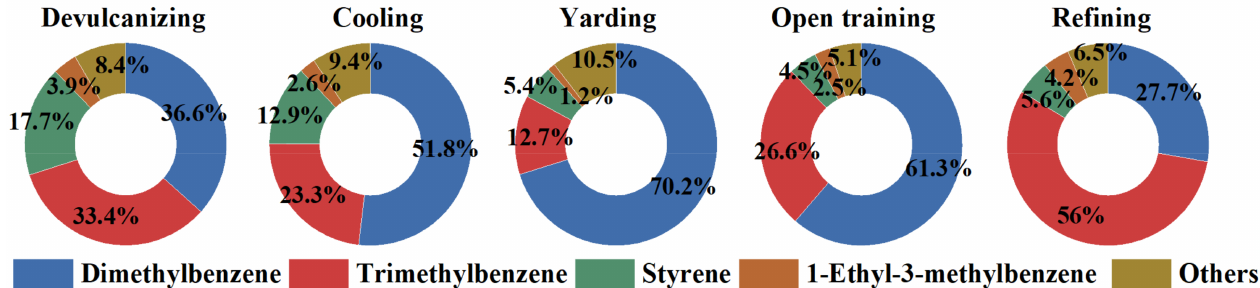
Figure 5. The L OH contribution of aromatics in each